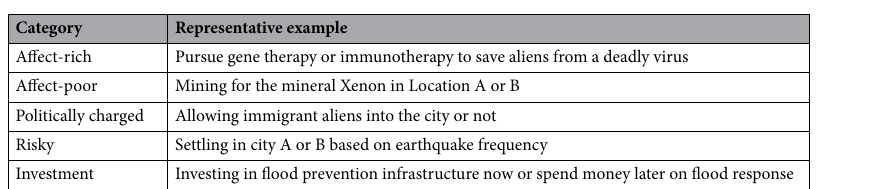
Table 1. Representative examples of issues under each category of